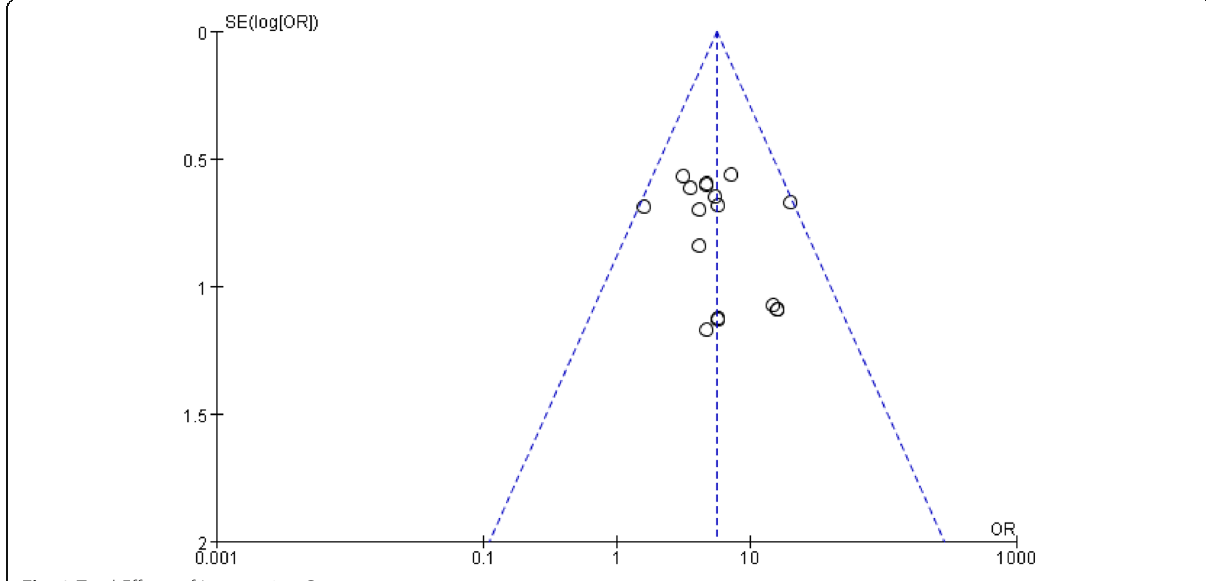
Fig. 9 Total Effects of Intervention